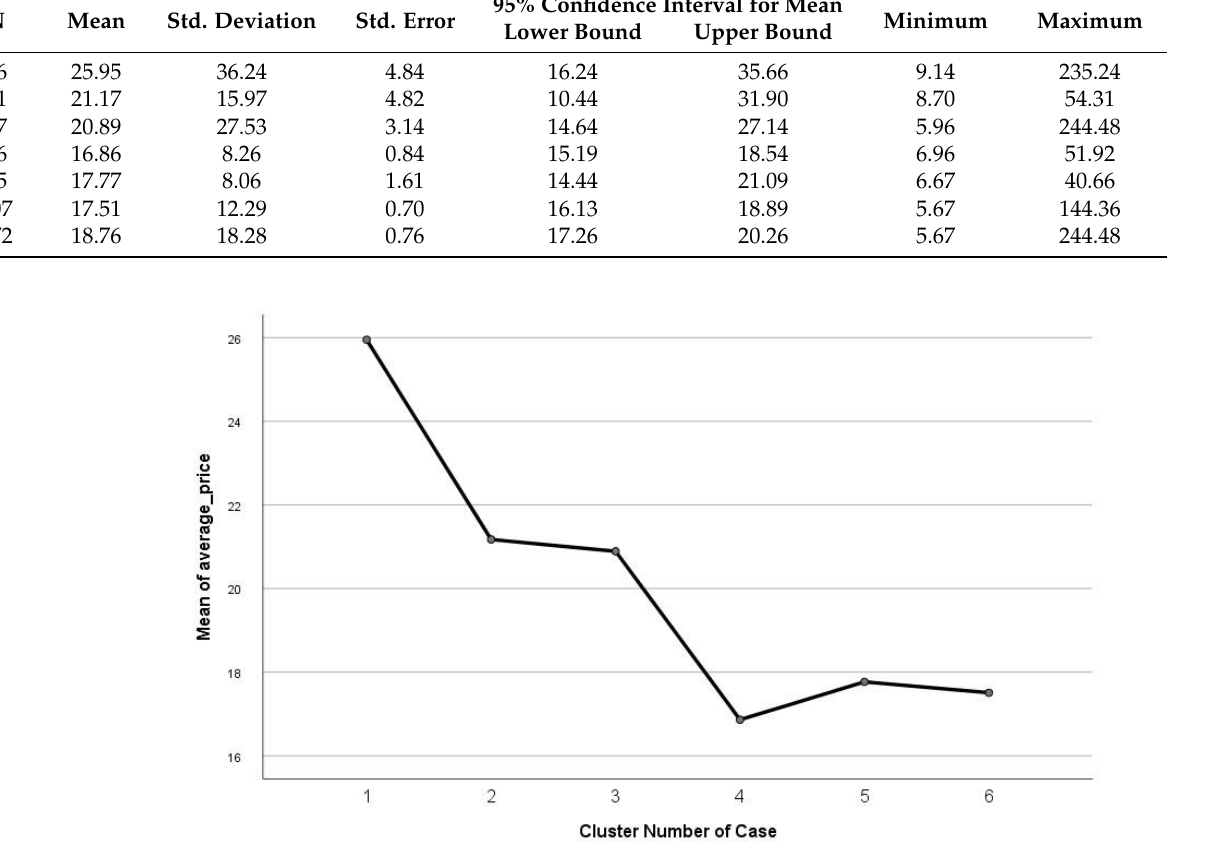
Figure 3. Mean bottled wine prices for six brand identity clusters.